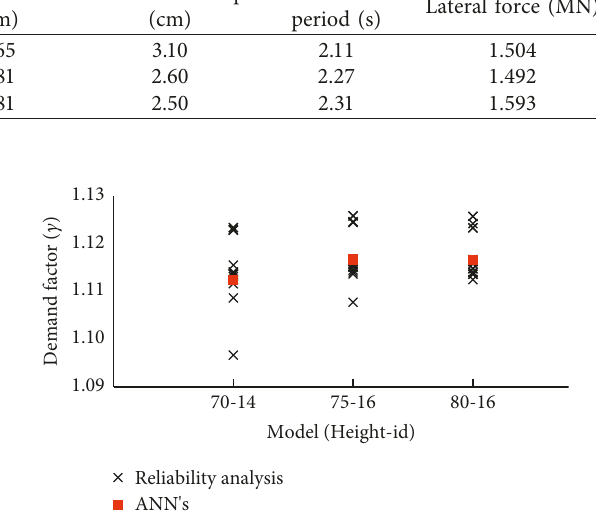
Figure 10: Structural demand factors corresponding to the veri- fication models.